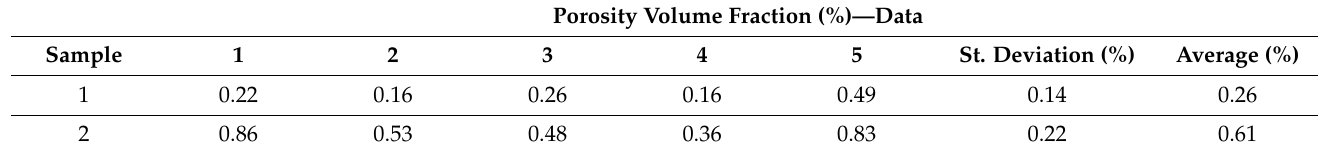
Table A4. Compression test porosity results of the second two specimens, compressed at 200 ◦ C and 10 min of dwell time, with various compaction pressures (sample 1 with 10 MPa, 2 with 8 MPa, 3 with 6 MPa, 4 with 4 MPA, 5 with 2 MPa).